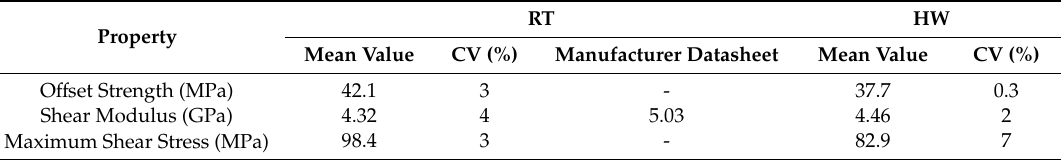
Table 8. Effect of hot-wet storage aging on the mechanical properties derived from static tension tests on [±45] laminates.